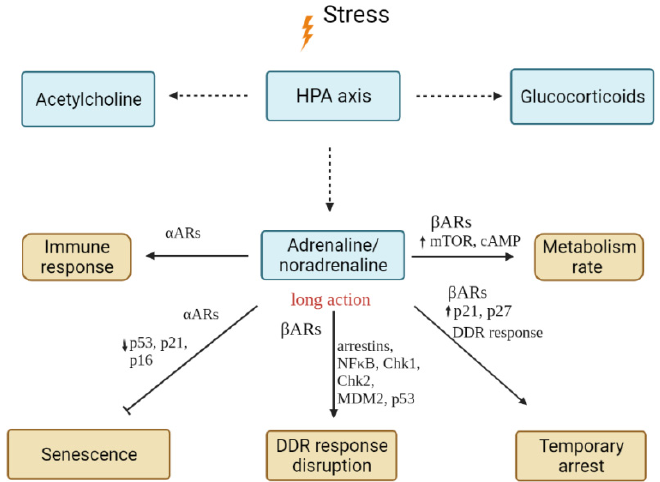
Figure 3. Schematic representation of effects of adrenaline and noradrenaline, sympathetic sys- tem neurotransmitters on intracellular processes and signalling pathways related to senescence, apoptosis, and cell cycle regulation. ↑ —stimulation, ↓ —inhibition, α ARs— α -adrenoreceptors, β ARs— β -adrenoreceptors.